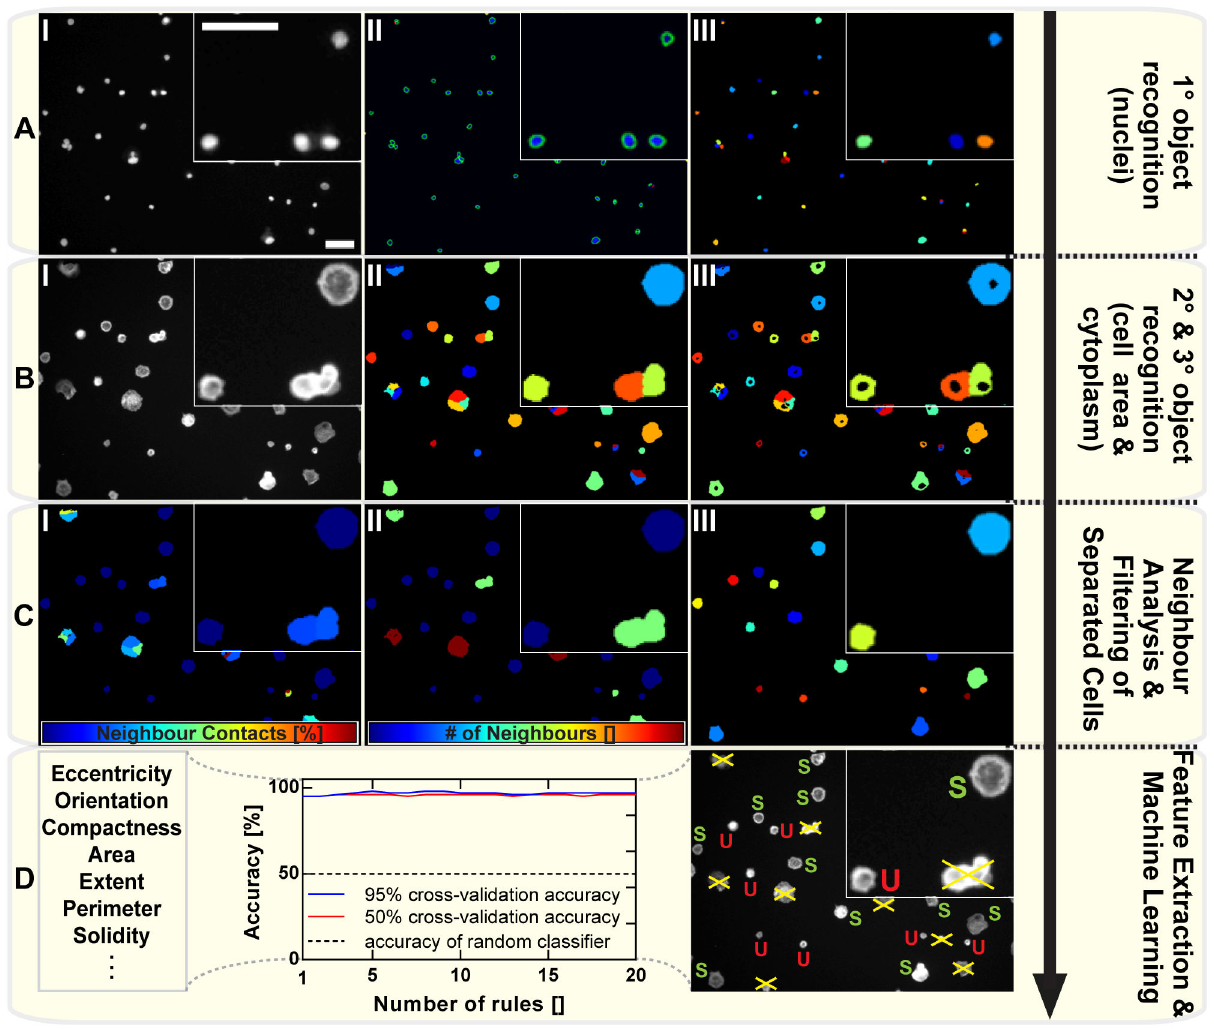
Figure 3. Data acquisition and feature extraction. A “High Content Screening” data acquisition pipeline was developed using the Cell Profiler software package: ( A ) Primary object recognition . DAPI stained cell nuclei (I) are detected and classified as primary objects (II). Nuclei touching the border, as well as nuclei outside the typical diameter range are excluded from the analysis (III). ( B ) Secondary and tertiary object recognition . Cell borders are detected in the Phalloidin channel (I) through a propagation function, that uses the DAPI nuclei (primary objects) as seeds to propagate outwards to the region of highest intensity (cell border). Again, cells touching the border of the image are excluded from analysis (II). Tertiary objects (cytoplasm) are generated by subtracting primary from secondary objects (III). ( C ) Neighbor analysis and filtering of separated cells . The amount of cell-cell interactions is measured by analyzing each cell’s fraction of membrane in contact with other cells (I) as well as the number of contacting neighbors (II). A filter is applied to extract all “separated cells” (no contact with other cells) (III). ( D ) Feature extraction and machine learning . All separated cells are subjected to a multi-parameter feature extraction. The information as well as compressed images of all channels is stored in an SQLite library and imported into Cell Analyst . Here, machine learning algorithms are generated to automatically discriminate spread (S) from unspread (U) cells. Thereby, the algorithms are built on a subset of cells that are categorized manually. The plot displays the typical cross-validation accuracy of a 3-class classifier (using 20 rules) applied to such a subset. - Magnification: Calibration bars in A(I) are applicable to all images of A-C and correspond to 50µm. doi: 10.1371/journal.pone.0078212.g003 and Nogo-A-Δ20 substrate. Cells show a greatly reduced The small, soluble GTPase RHOA is known to mediate the spreading phenotype characterized by reduced cytoplasm- inhibitory effects of Nogo-A on neurite outgrowth and cell areas and cell rounding. spreading [7,16]. The rho-associated protein kinase (ROCK)